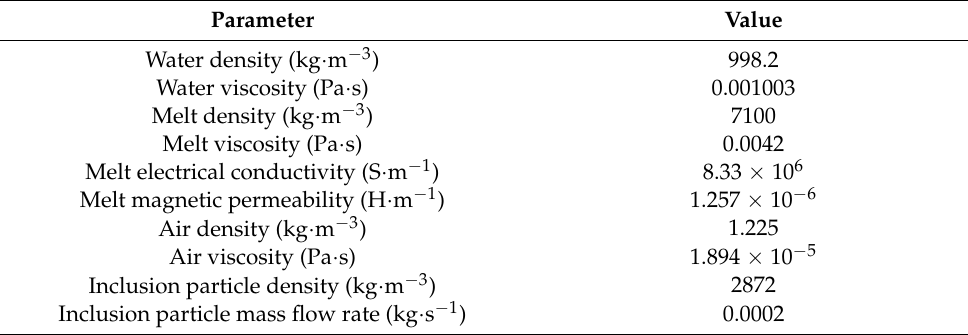
Table 1. Physical parameters adopted in the simulation [22,26,33].